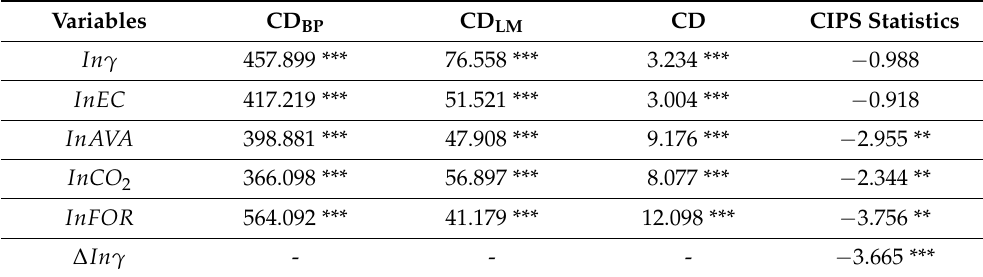
Table 3. Cross-section dependence and panel unit root tests for the